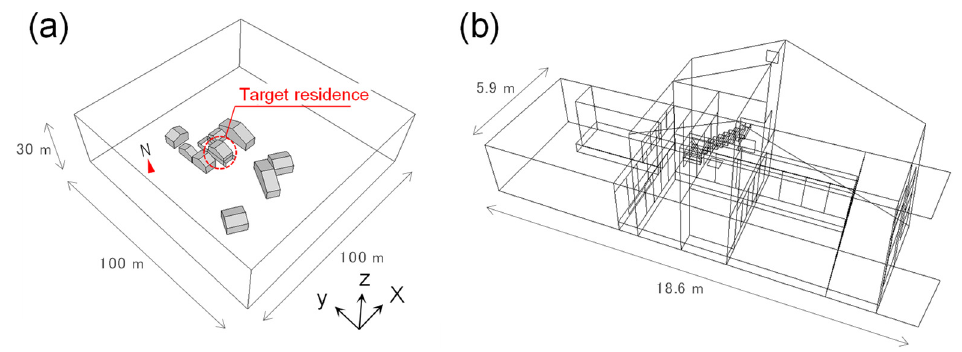
Figure 9. ( a ) Computational domain and ( b ) the wire frame model of the target residence. Here, the effects of opening/closing the Fusuma (Japanese-style partition door) were examined according to Patterns 1–3 (Figure 10). In Pattern 3, the cases with stronger outside wind (3.0 m/s, 3.5 m/s) were also examined.